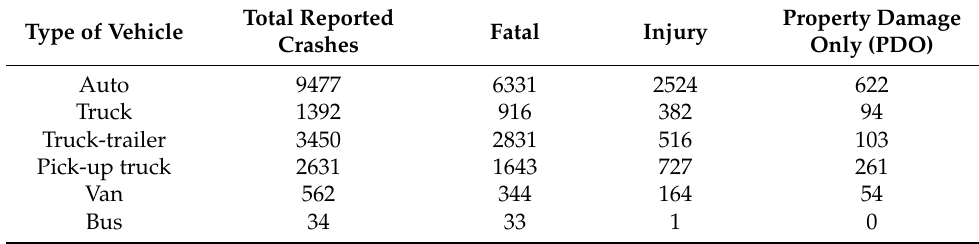
Table 1. Injury Severity of Drivers in Crashes at HRGCs